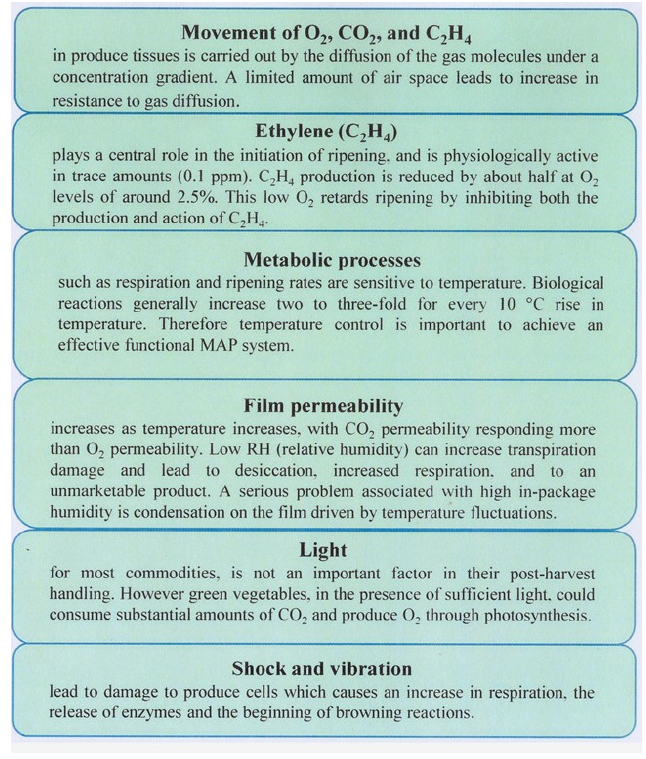
Figure 2. Factors affecting MAP of fresh products